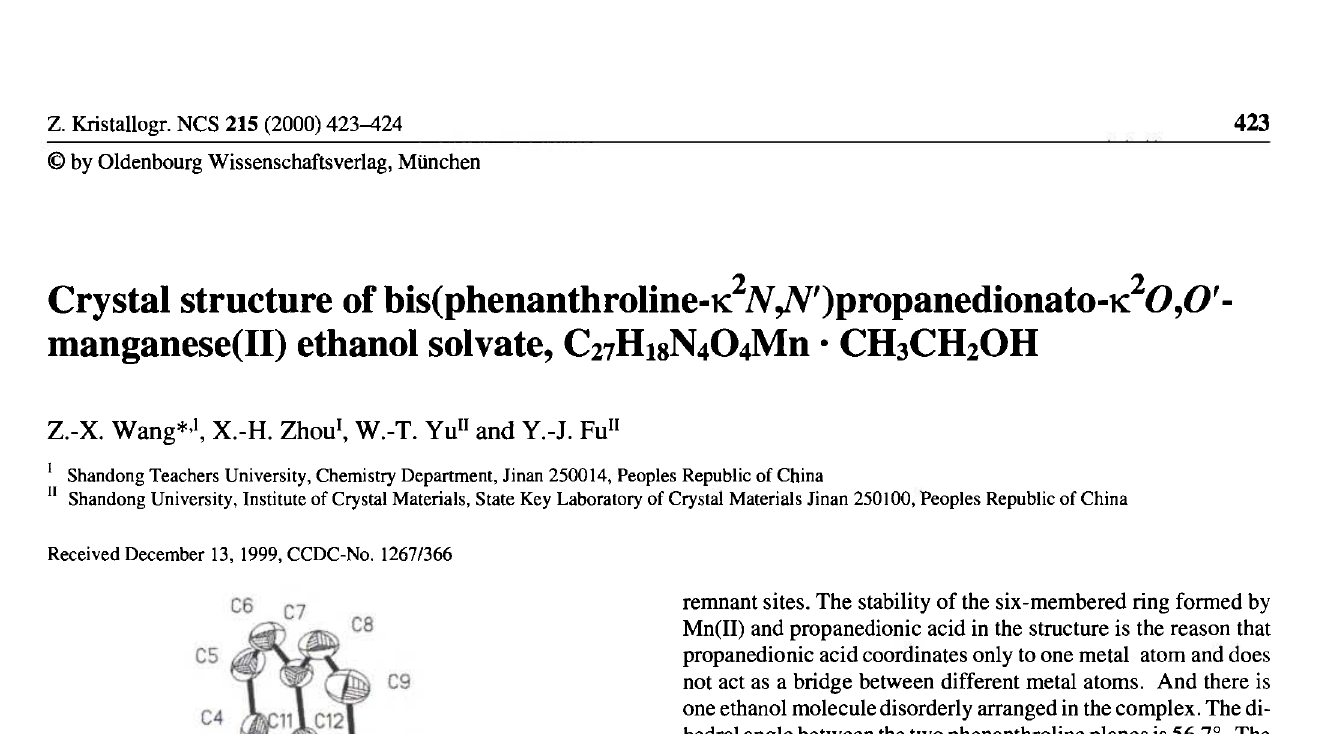
Table 1. Data collection and handling.